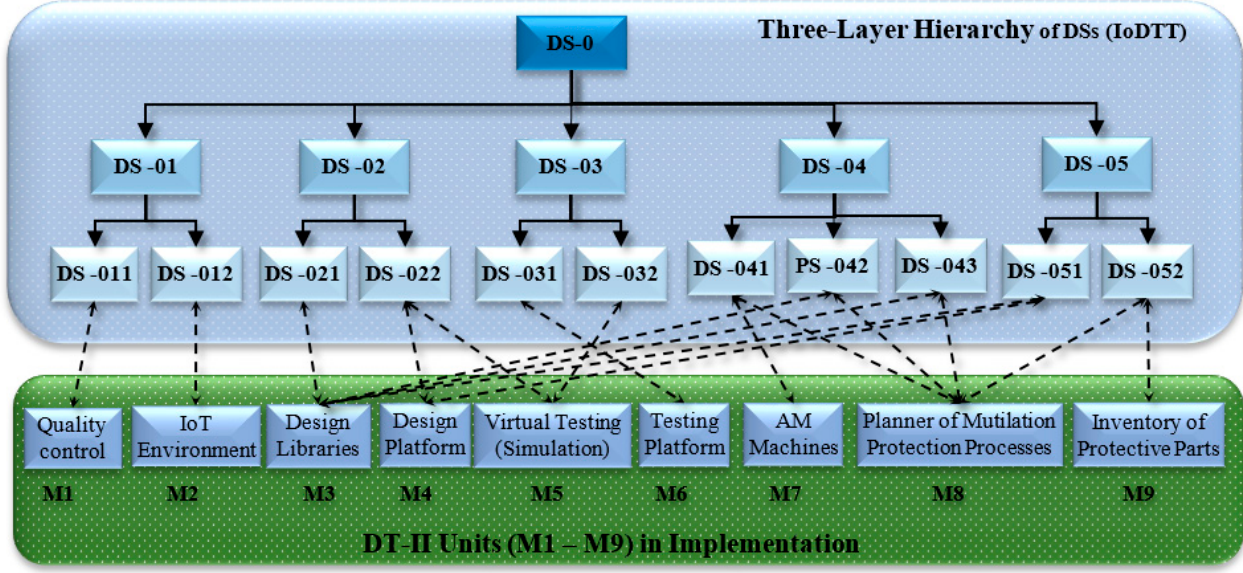
Figure 4. Proposed digital solutions in case study 2 (Reprinted with permission from ref. [7]. 2021 Taylor & Francis).